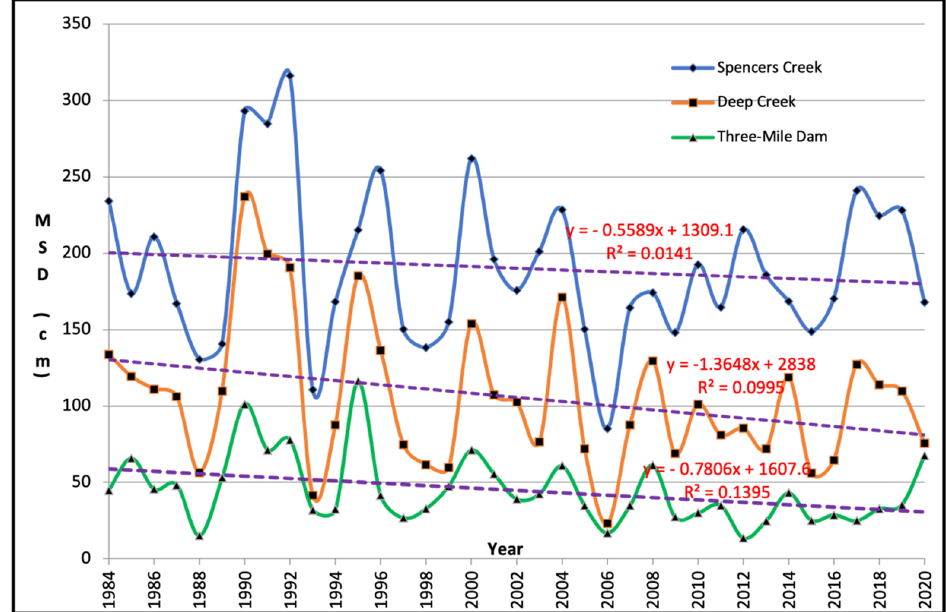
Figure 4. Interannual time series of the observed MSDs at the three snow observations sites. The linear regression line for each site with explained variance is shown.